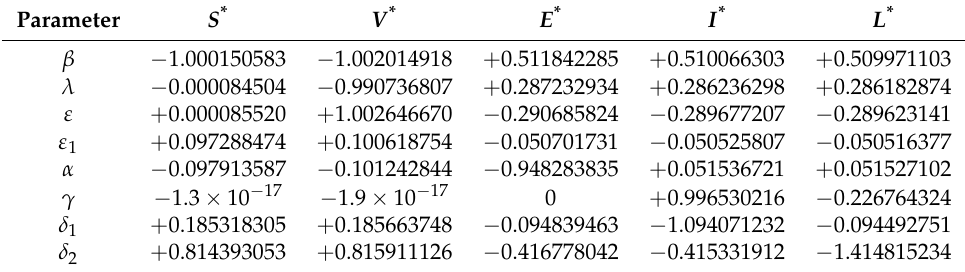
Table 3. Sensitivity indices of the endemic